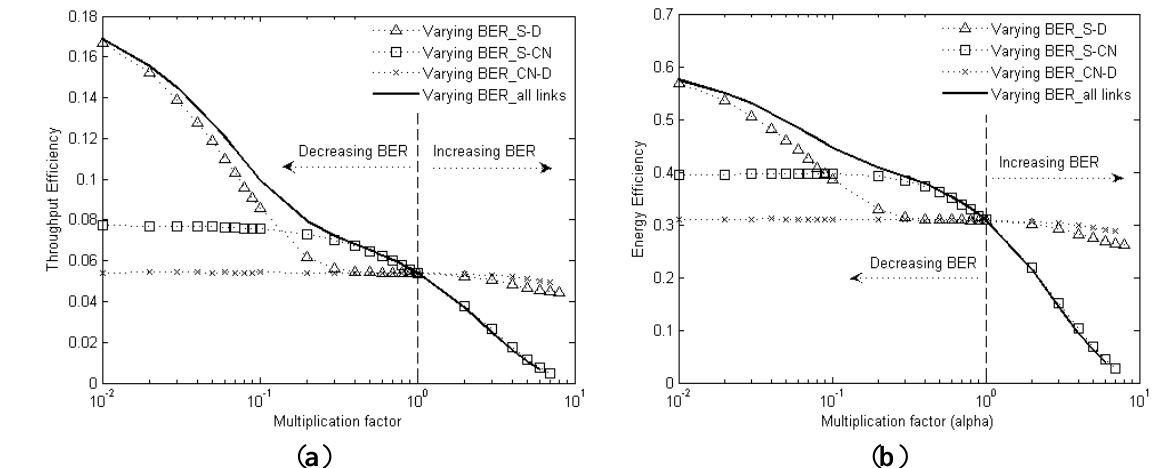
Figure 9. ( a ) Throughput efficiency and ( b ) Energy efficiency dependence on BER